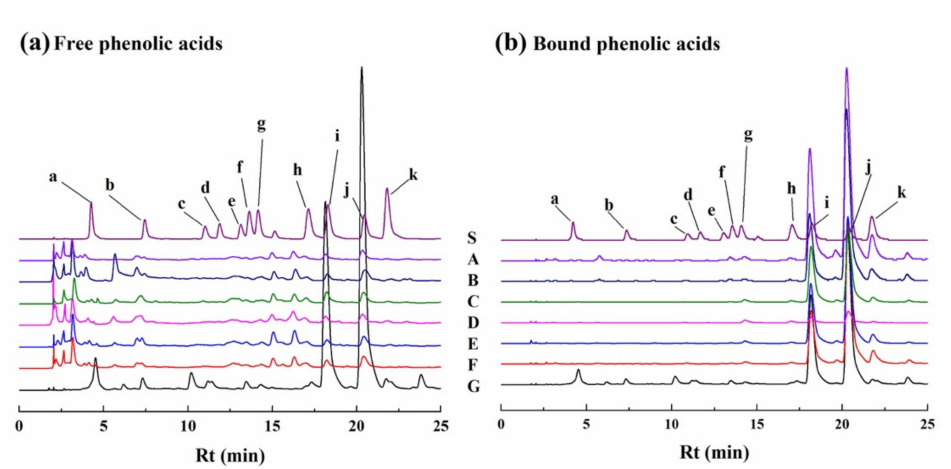
Figure 3. HPLC chromatograms (280 nm) of free phenolic compounds ( a ) and bound phenolic compounds ( b ) extracted from seven varieties of brown rice. (S, standard mixture of phenolic acids; A, Guangliangyouxiang-66; B, Zhaoyou-5431; C, Ezhong No.5; D, Juliangyou-60; E, Y liangyou-900; F, Zhongzheyou No.8; G, Luotiangongmi; a, Gallic acid; b, Protocatechuic acid; c, p -Hydroxybenzoic acid; d, Chlorogenic acid; e, Vanillic acid; f, Caffeic acid; g, Syringic acid; h, Vanillin; i, p -Coumaric acid; j, Ferulic acid; k, trans -3-Hydroxycinnamic acid). Based on the comparison to phenolic standards, the contents of these phenols and their corresponding percentage contribution in free and bound fractions were calculated and are presented in Table 2. Table 2. Quantitative analysis of identified phenolic compounds in seven varieties of brown rice